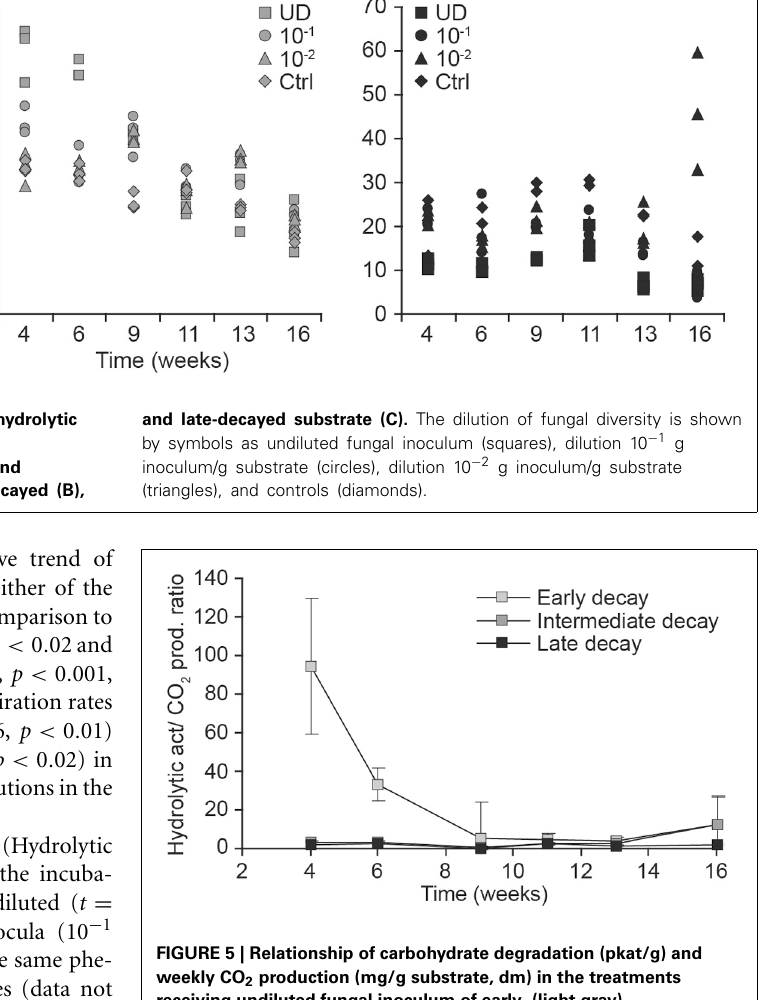
FIGURE 5 | Relationship of carbohydrate degradation (pkat/g) and weekly CO 2 production (mg/g substrate, dm) in the treatments receiving undiluted fungal inoculum of early- (light gray), intermediate- (dark gray), and late- (black) decay substrate during the 16-week